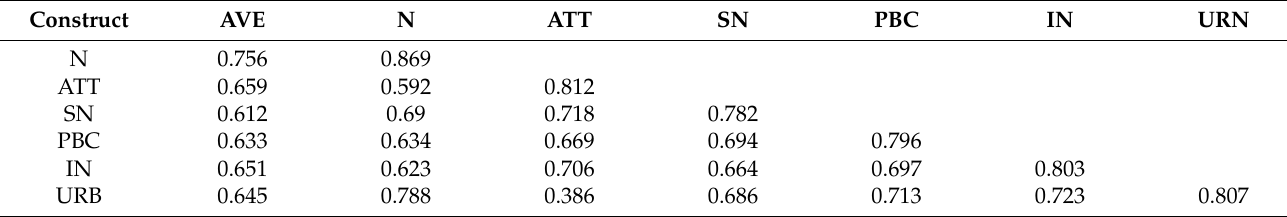
Table 5. Results of discriminant